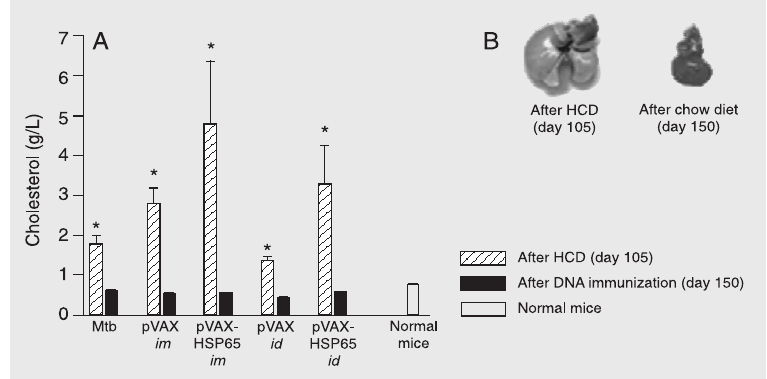
Figure 1. Serum cholesterol levels and macroscopic liver alterations in mice submitted to an atherosclerosis-induction protocol. Female C57BL/6 mice (4-6 mice per group) were fed an atherogenic diet (high cholesterol diet, HCD) for 105 days associated with 3 doses of 250 µg heat-killed M. tuberculosis (Mtb) on days 0, 15, and 30. On day 105, the animals started to receive a normal chow diet and were immunized with DNA (4 doses of 100 µg pVAX-HSP65 by the intramuscular ( im ) or intradermal ( id ) route (with a gene gun) on days 105, 115, 125, and 135. The following control groups (4-6 mice per group) were included: Mtb (animals fed the HCD and immunized with Mtb); pVAX im and pVAX id (animals fed the HCD, immunized with Mtb and injected with the empty vector by the im or id route); normal mice (animals fed a chow diet). A , Serum cholesterol levels were measured in samples collected on the 105th day (end of the HCD) and on the 150th day (end of the experiment, 15 days after the last DNA immunization). B , Macroscopic liver alterations observed on the 150th day included a change in color to yellowish and an increased size. *P < 0.05 compared with normal mice (ANOVA followed by Tukey test)